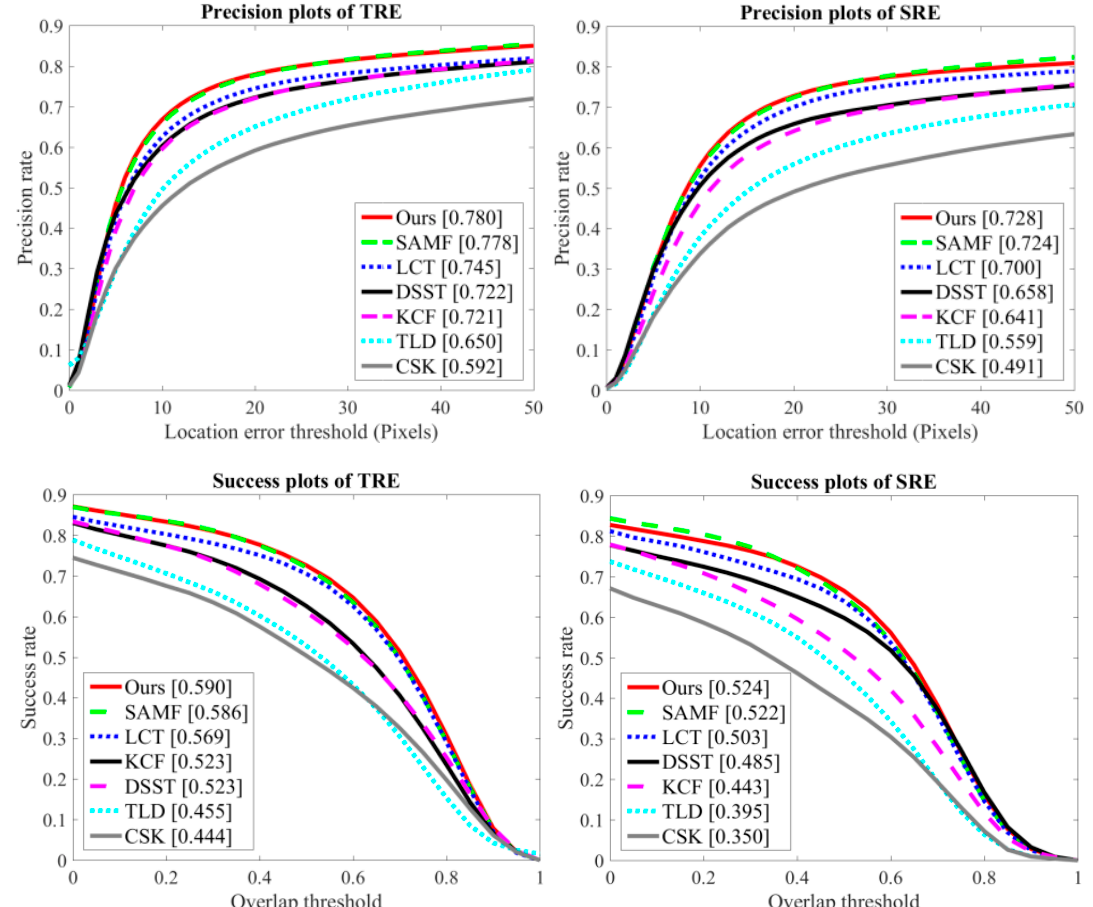
Figure 4. Precision and success plots on OTB-2015 using TRE and SRE.